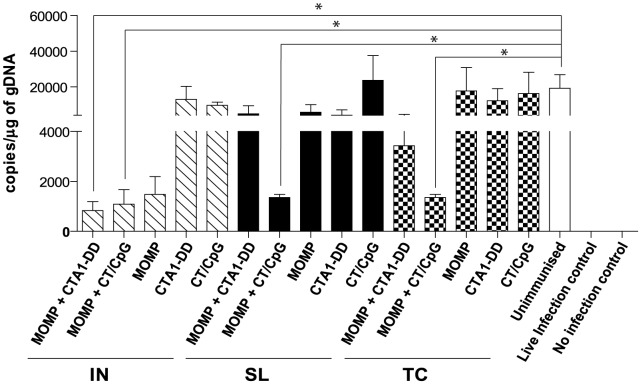
Chlamydial burden in lung tissue at day 10 p.i determined by ompA PCR.Genomic DNA (gDNA) was extracted from lung tissues collected at day 10 p.i. Chlamydial DNA was quantified from lung gDNA by ompA-specific qRT-PCR using a standard curve. The copies of C. muridarum DNA per µg of host gDNA for each vaccine were grouped with their respective route of immunization. Results are presented as the mean ± SD. Significant differences were determined using a one-way ANOVA with Tukey’s post-test. Significance was set at P<0.05 for all tests. P>0.05 (not shown), 0.01–0.05 (*), 0.001–0.01 (**) and <0.001 (***).